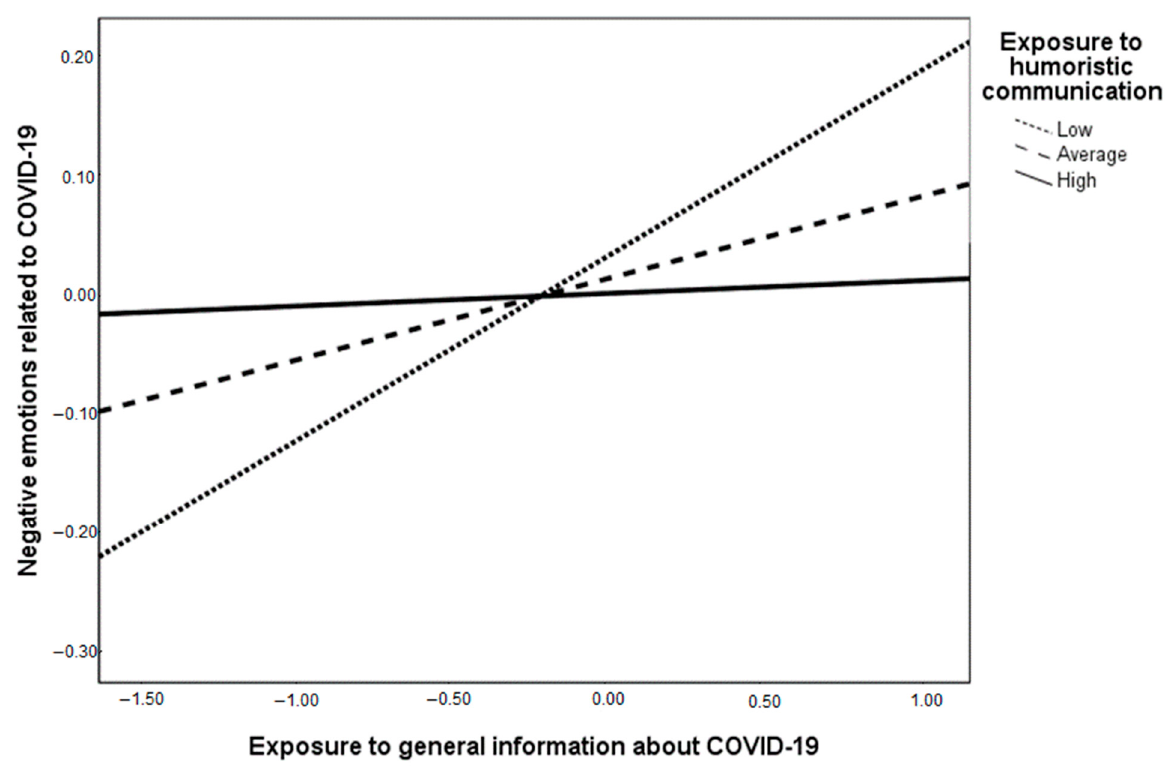
Figure 2. The interaction between exposure to general information and exposure to humoristic communication (EHC) on negative emotions in relation to COVID-19. Note: conditional effects of exposure to general information about COVID-19 on negative attitudes are: B = 0.15, SE = 0.05, p = 0.001 for low EHC; B = 0.07, SE = 0.04, p = 0.05 for average EHC and B = 0.01, SE = 0.04, p = 0.80 for high EHC.